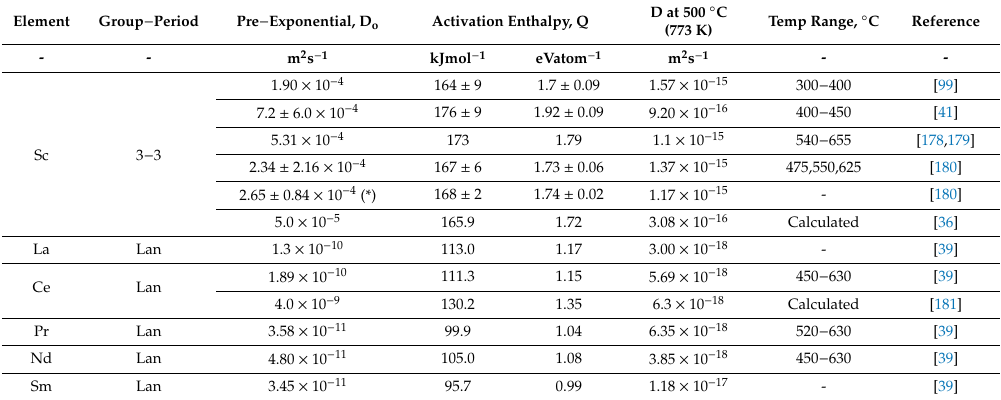
(*) results of combining measurements in [157,180] with literature data. Additional di ff usion data: